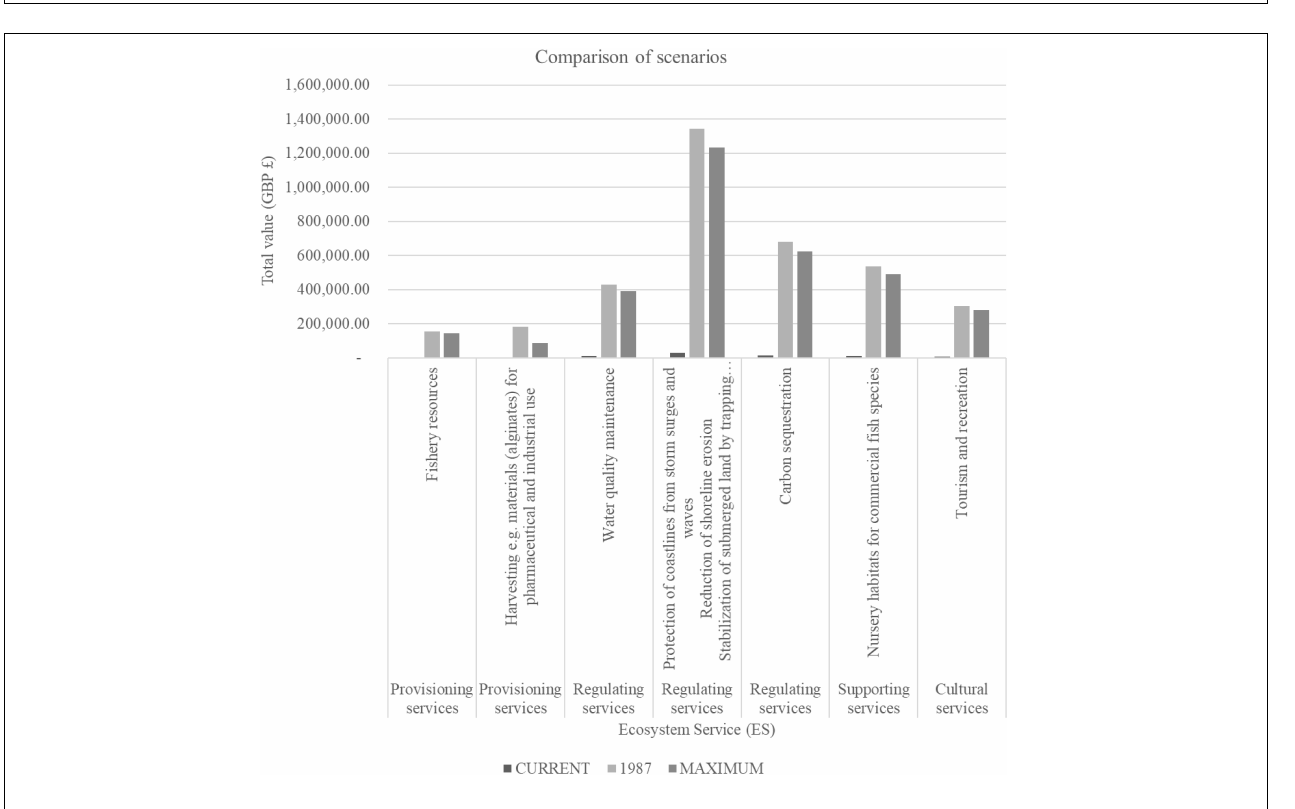
FIGURE 5 | Comparison of the results for all three